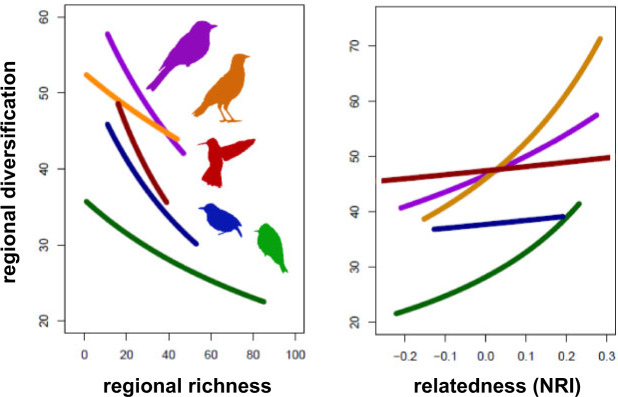
Regional diversification, richness, and possible competition. In each of the five taxa, regional diversification declines with regional richness (left panel). Moreover, regional diversification is suppressed in regions that host unrelated species (NRI \documentclass[12pt]{minimal}
\usepackage{amsmath}
\usepackage{wasysym}
\usepackage{amsfonts}
\usepackage{amssymb}
\usepackage{amsbsy}
\usepackage{upgreek}
\usepackage{mathrsfs}
\setlength{\oddsidemargin}{-69pt}
\begin{document}
}{}$<<$\end{document} 0), as expected under increased regional competition (right panel). Taxon-specific silhouettes and color-coding correspond with the preceding figures. The vertical axis indicates relative differences in regional diversification. Full results, including the absolute differences, regression lines, data points, and summary statistics for each taxon separately, are provided in the Supplementary Figures S33–S37 available on Dryad.